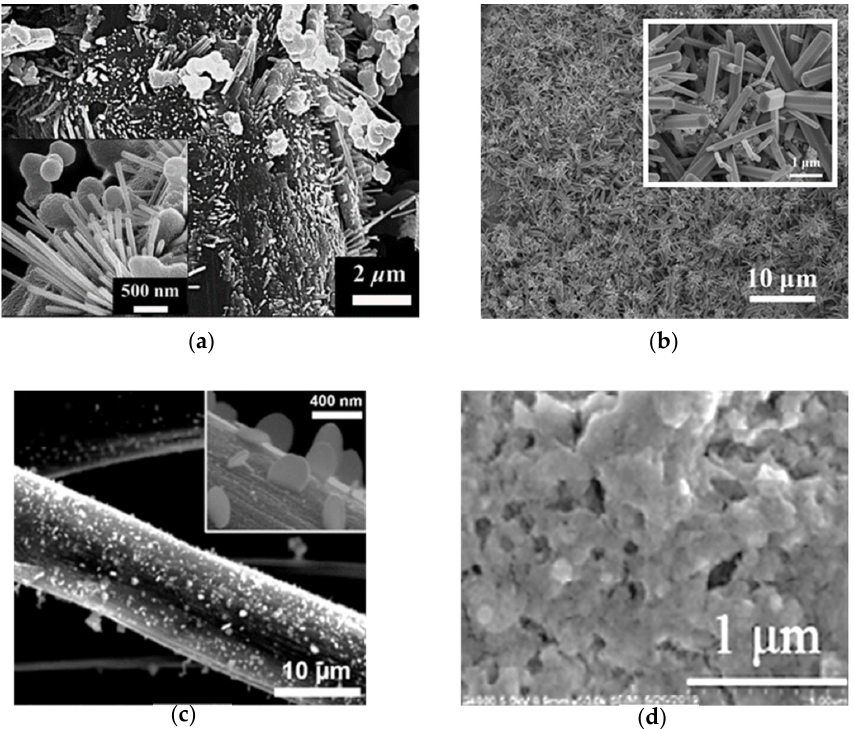
Figure 8. The SEM images of ( a ) TiO 1.1 Se 0.9 /CC [78], ( b ) CoSe 2 /CoSeO 3 -UL [79], ( c ) T d -Mo 0.29